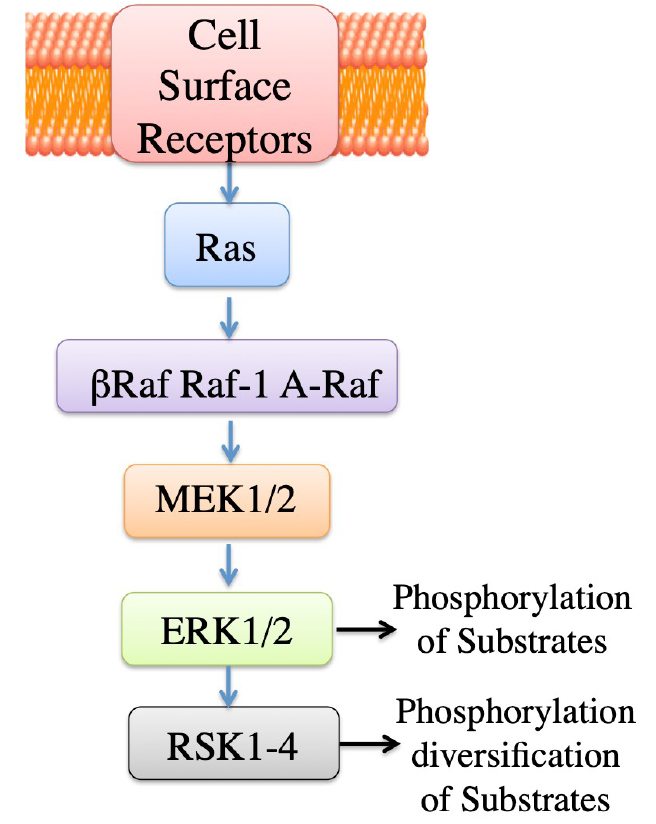
Figure 3. Simplified schematic of the ERK signaling cascade. Activation processes are indicated. Raf family members bind Ras / GTP (not shown). Raf isoforms activate ERK kinase (MEK). Activated ERK has many substrates. Downstream of ERK1 / 2 is the RSK family with various isoforms, which participate in ERK signaling and diversification of the signal. Adapted from the works of [122,123].